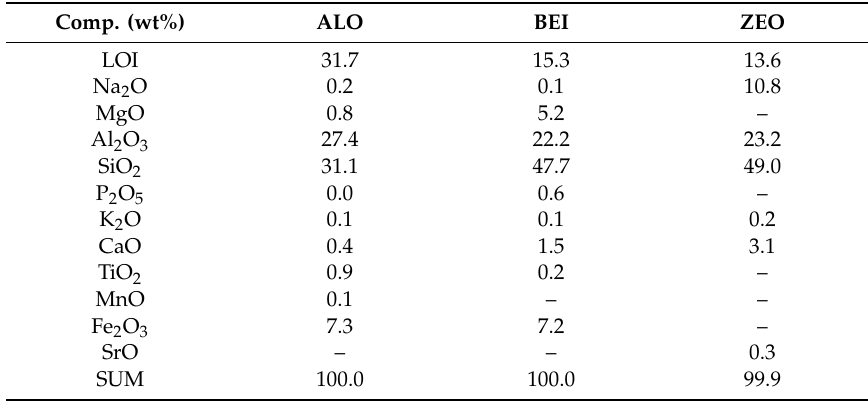
Fe 2 O 3 was added to each raw material (FeO-ALO, FeO-BEI and FeO-ZEO). Comp.